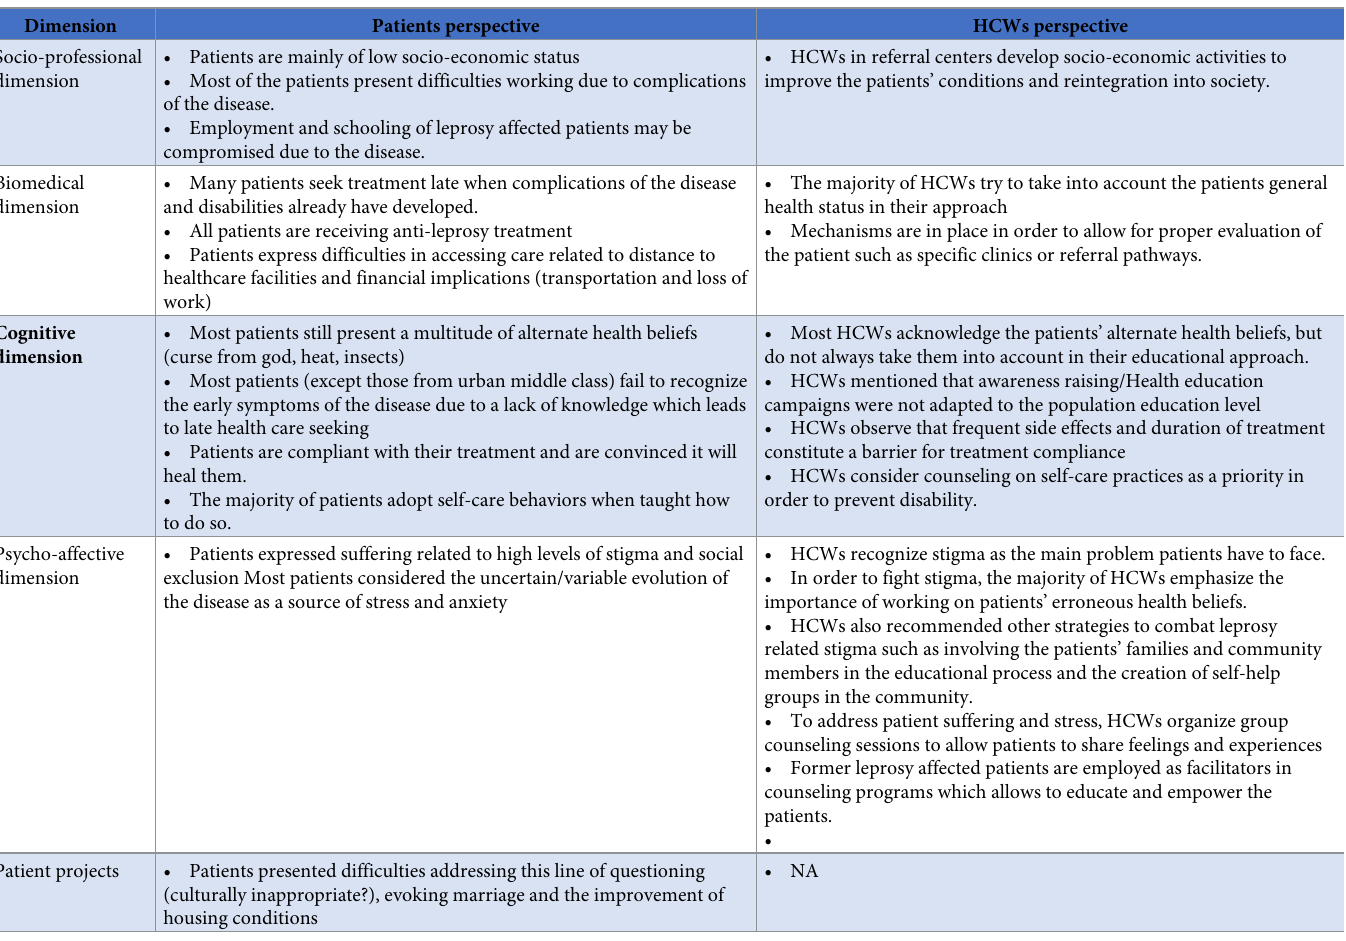
Table 2. Summary of patients and HCWs